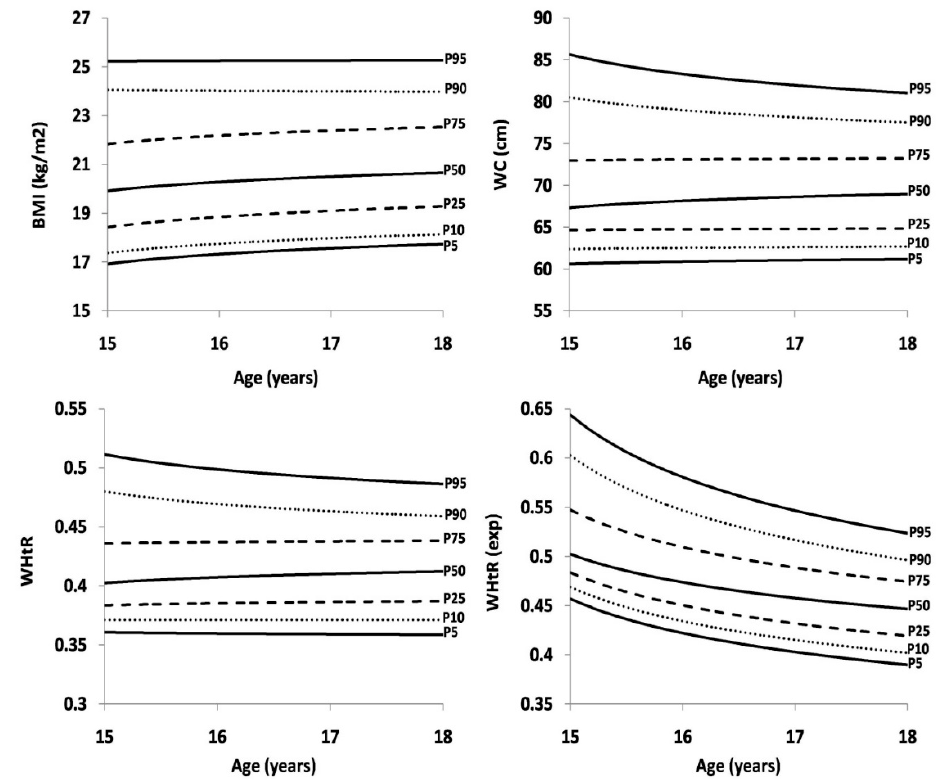
Figure 2. Age-specific reference curves for BMI, WC, WHtR and WHtR (exp) in girls.